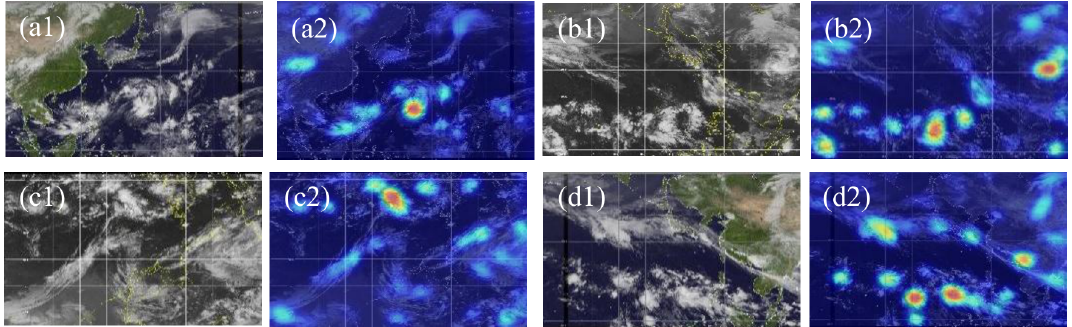
Figure 16. Non-TC images misjudged as TC images and associated heat maps.